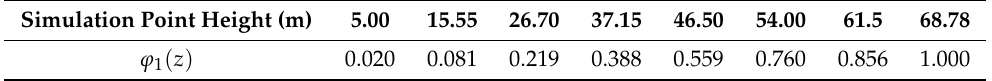
Table 5. First-order vibration coefficients of the